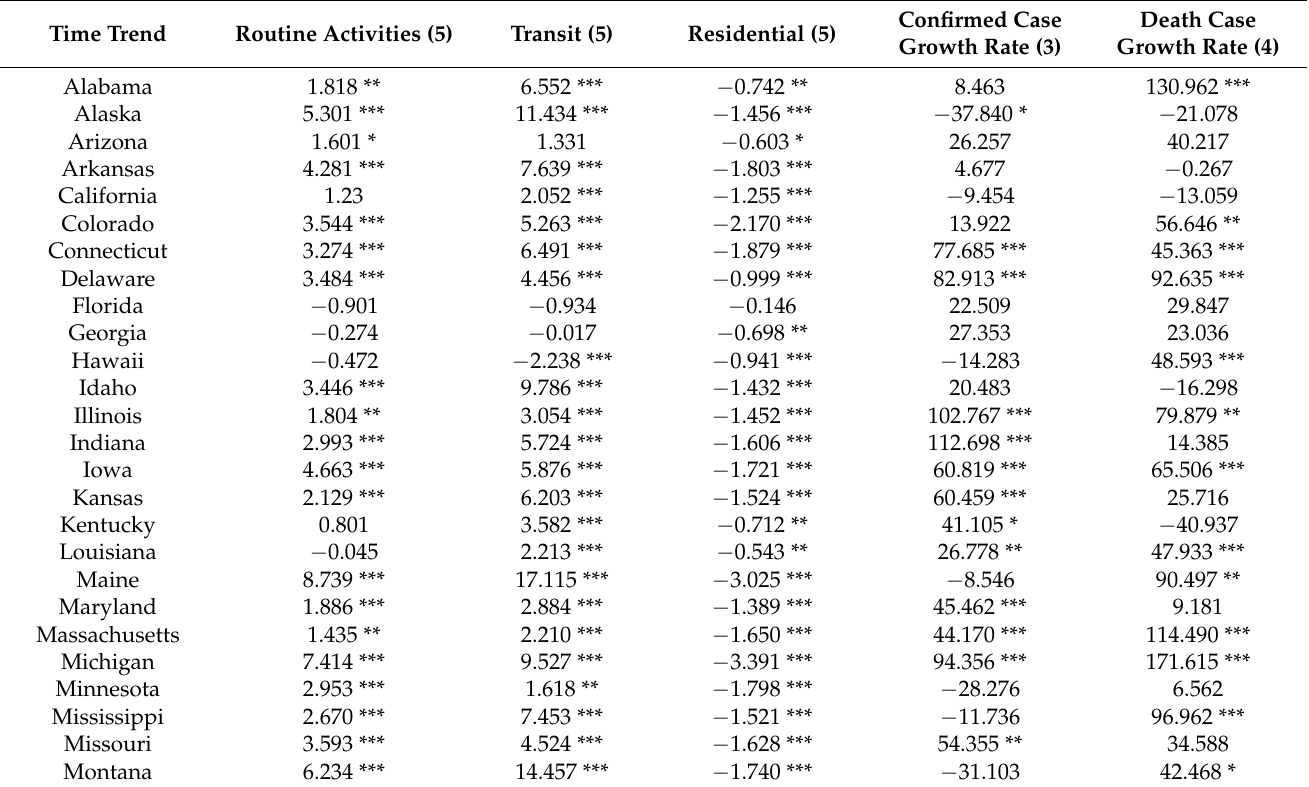
Table A1. State-specific time trends (as part of Table 2 in the main text).